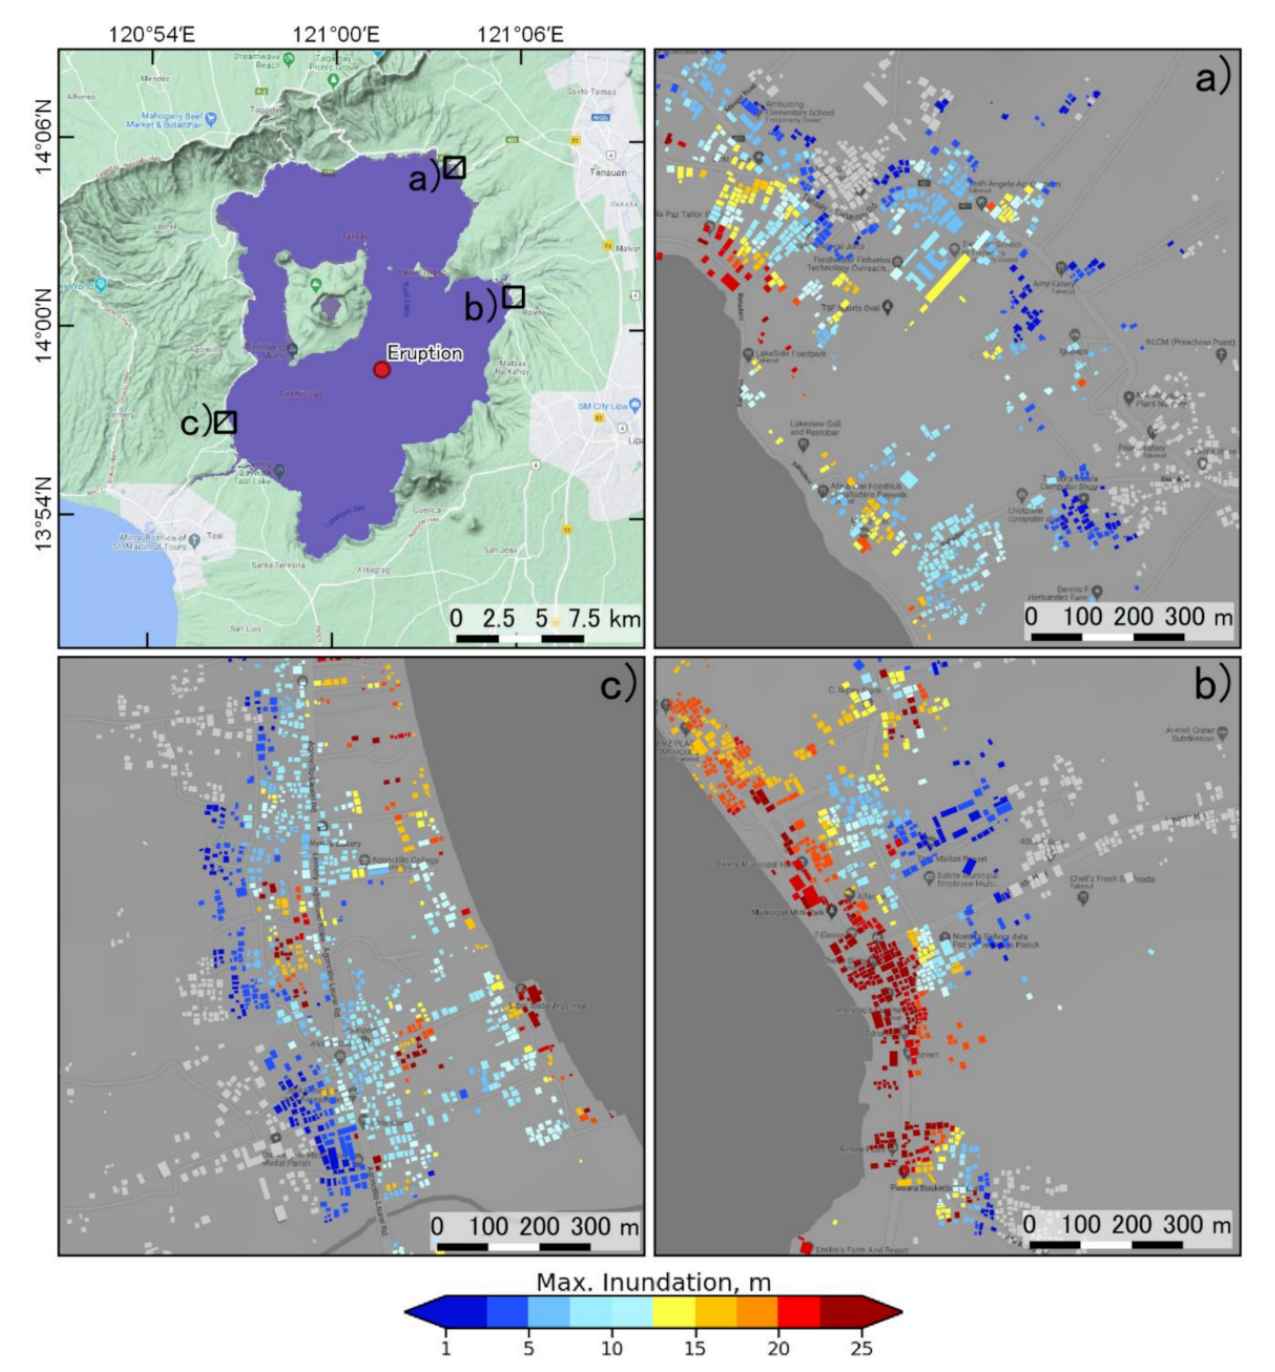
Figure 10. Tsunami hazard map showing the maximum inundation depths for the buildings with a probability of 1/100 in some example areas. ( a ) northern coastal area, ( b ) coastal area near to the eruption point, and ( c ) southern coastal